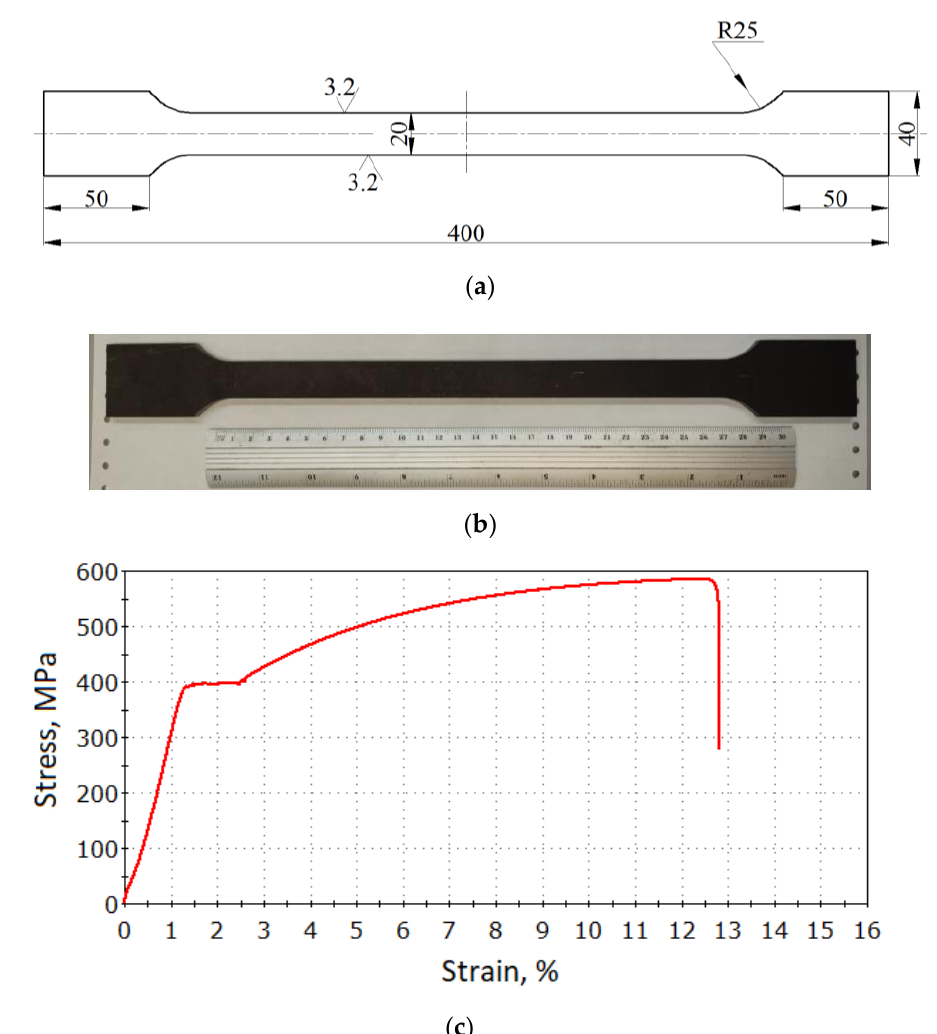
Figure 1. Scheme ( a ) and photo ( b ) of a specimen for tensile test for mechanical properties evaluation and stress-strain curve ( c ) of a specimen from the 30 KhGSA steel. Table 2. Mechanical properties of the 30 KhGSA steel (results of 6 specimens test).